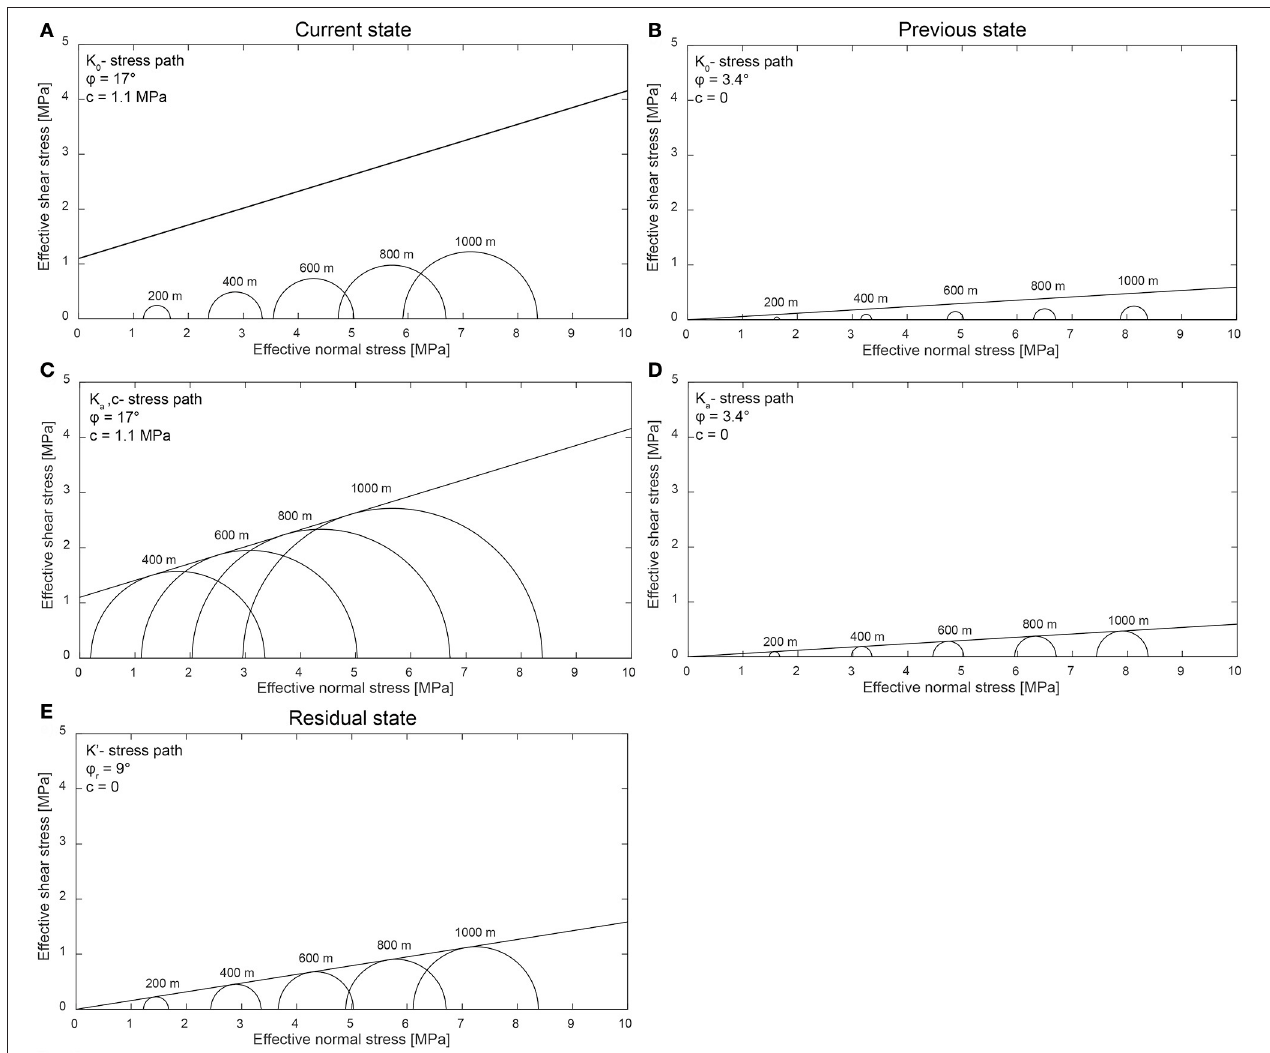
FIGURE 13 | (A) Mohr circles of effective stresses for burial under earth pressure at rest (K 0 ) relative to Coulomb failure envelope based on current mechanical properties of the lower Hordaland Group (Wensaas et al., 1998); (B) Mohr circles of effective stresses for burial under earth pressure at rest (K 0 ) relative to Coulomb failure envelope based on mechanical properties of “weak” clays ( Moore and Lockner, 2007), as expected during shallow burial; (C) Mohr circles of effective stresses for burial for active earth pressure (K a ) relative to Coulomb failure envelope with cohesion and friction angle of the lower Hordaland Group (Wensaas et al., 1998); (D) Mohr circles of effective stresses for burial for active earth pressure (K a ) relative to Coulomb failure envelope based on mechanical properties of “weak” clays (Moore and Lockner, 2007), as expected during shallow burial; (E) Mohr circles of effective stresses for burial for earth pressure (K ′ ) relative to Coulomb failure envelope for low coefficients of residual friction ( φ r ≈ 9 ◦ ; Bishop et al.,